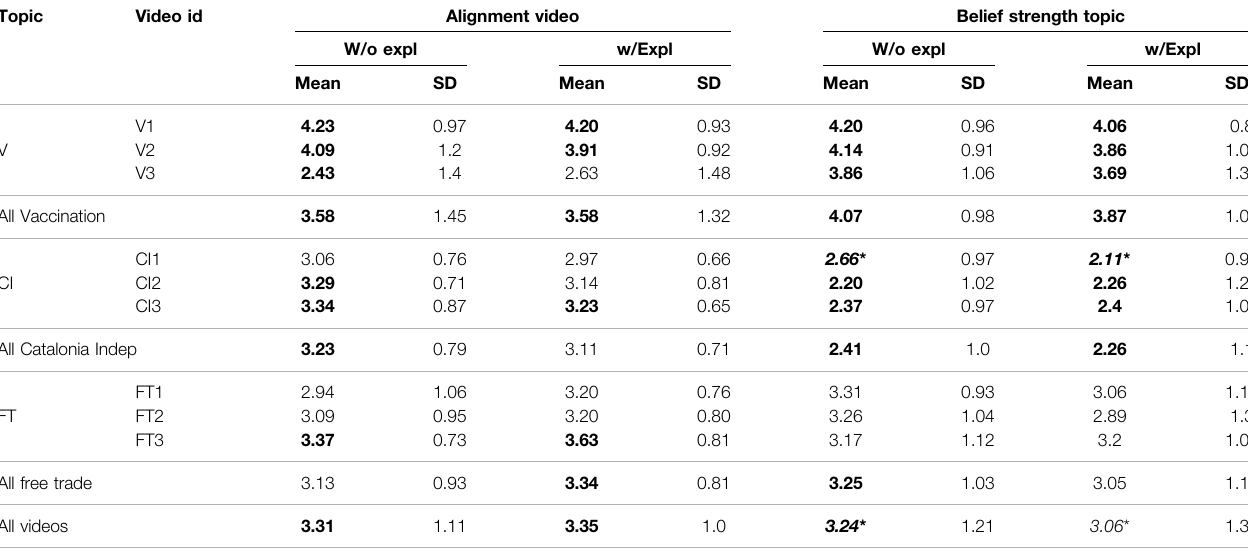
TABLE 4 | Mean and SD for variables alignment on the video and belief strength on the topic, without and with explanations. Topic Video id Alignment video